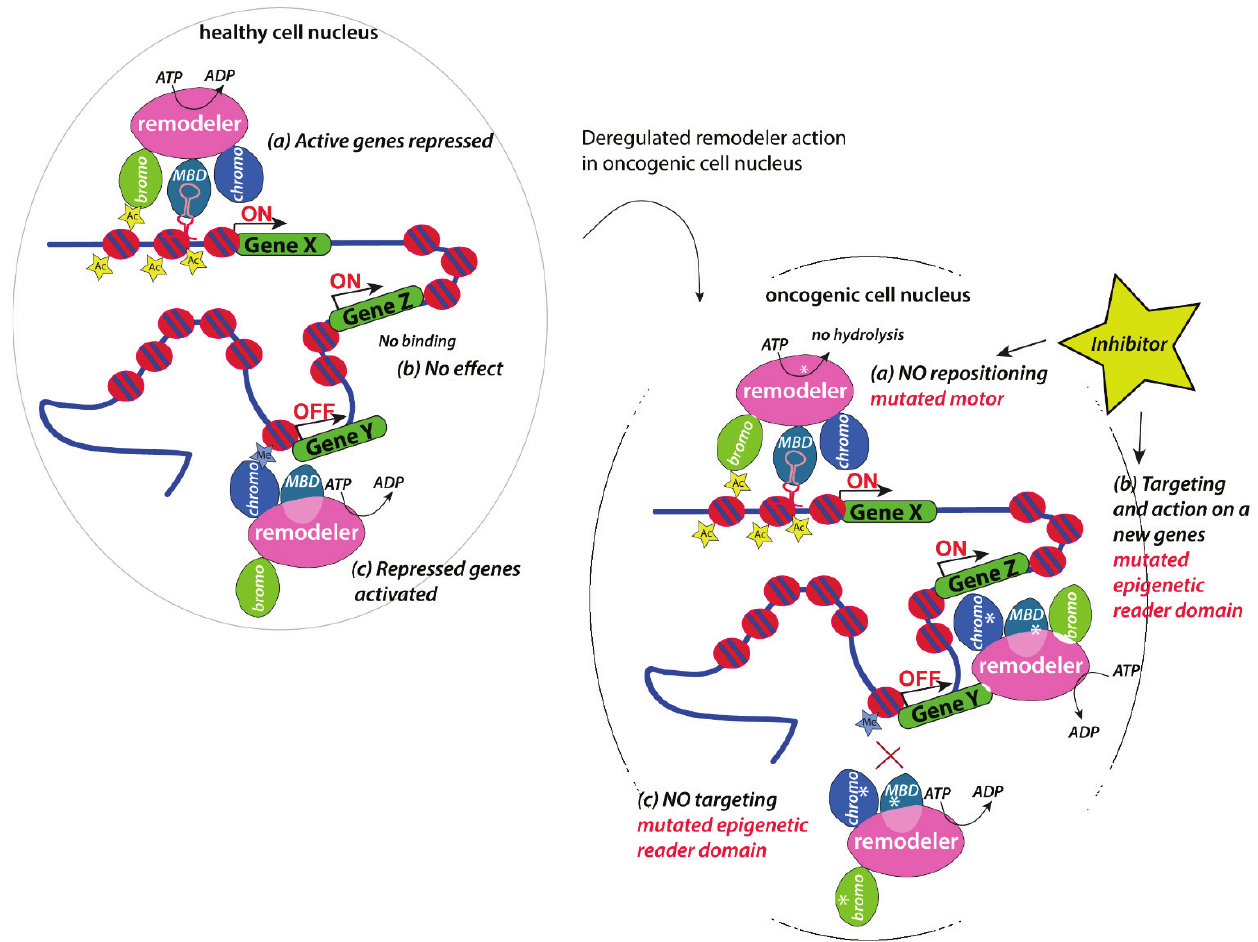
Figure 4. Model describing the potential activities of deregulated chromatin remodelers in an oncogenic cell. Chromatin remodelers that involved in the repression of active genes, or maintaining genes repressed ( a ), might loose their activity on the particular gene. The same could occur with activities acting on repressed genes ( b ). Mutations in the reader domains could result in targeting of the complexes to non-genuine targets altering its activity status ( c